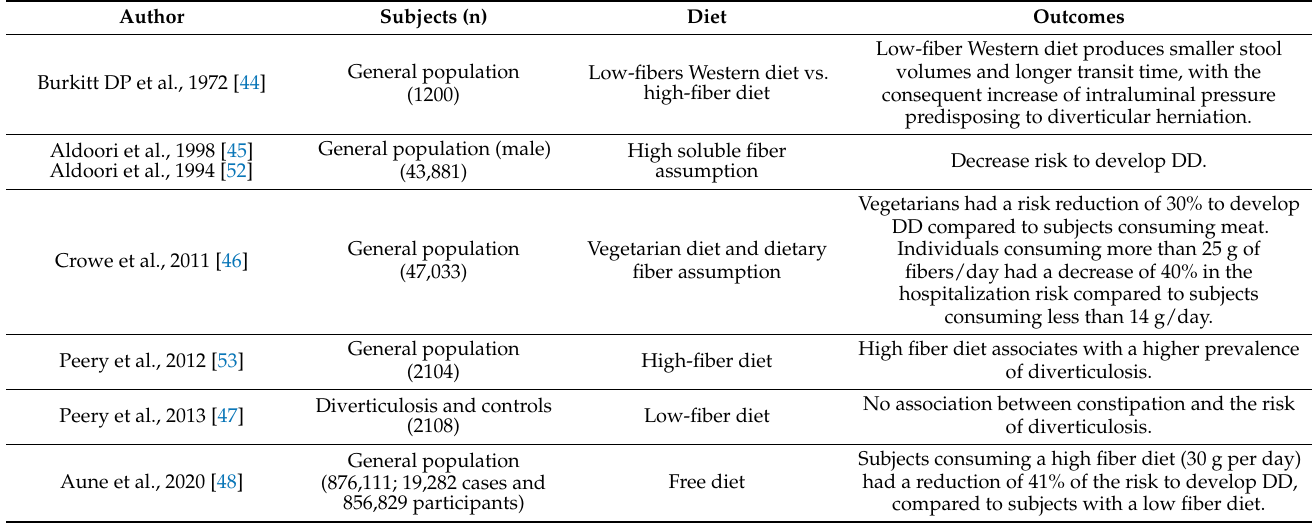
Table 2. Main studies assessing fiber role in